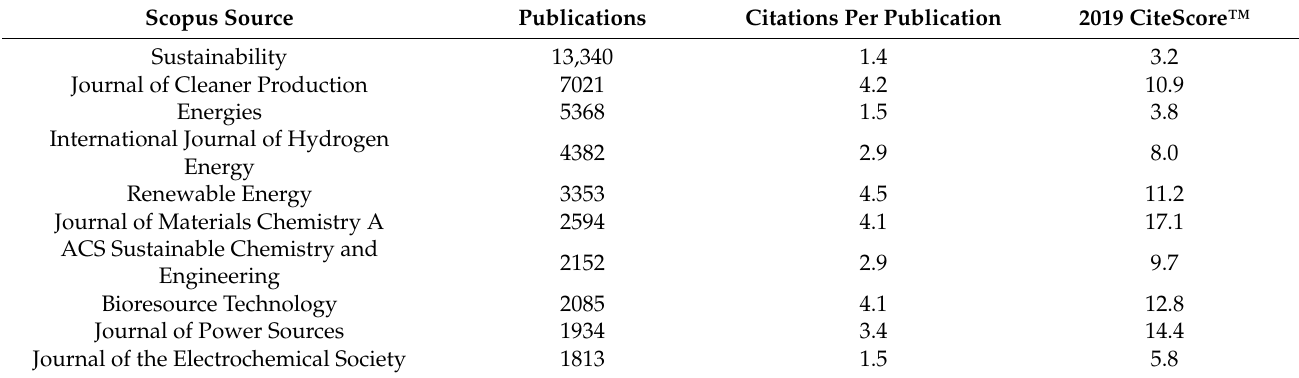
Table 3. Top 10 Scopus sources by publications on renewable energy, sustainability and the environment in 2020–2021. Scopus Source